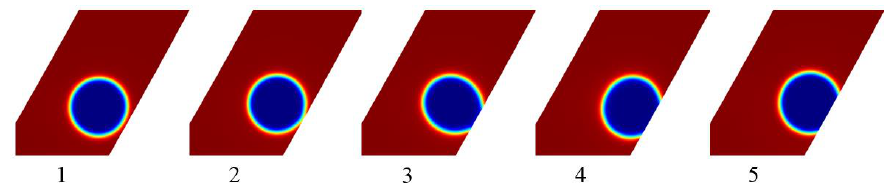
Figure A4. The COMSOL simulation of the centrifugal driving of W/O droplet.